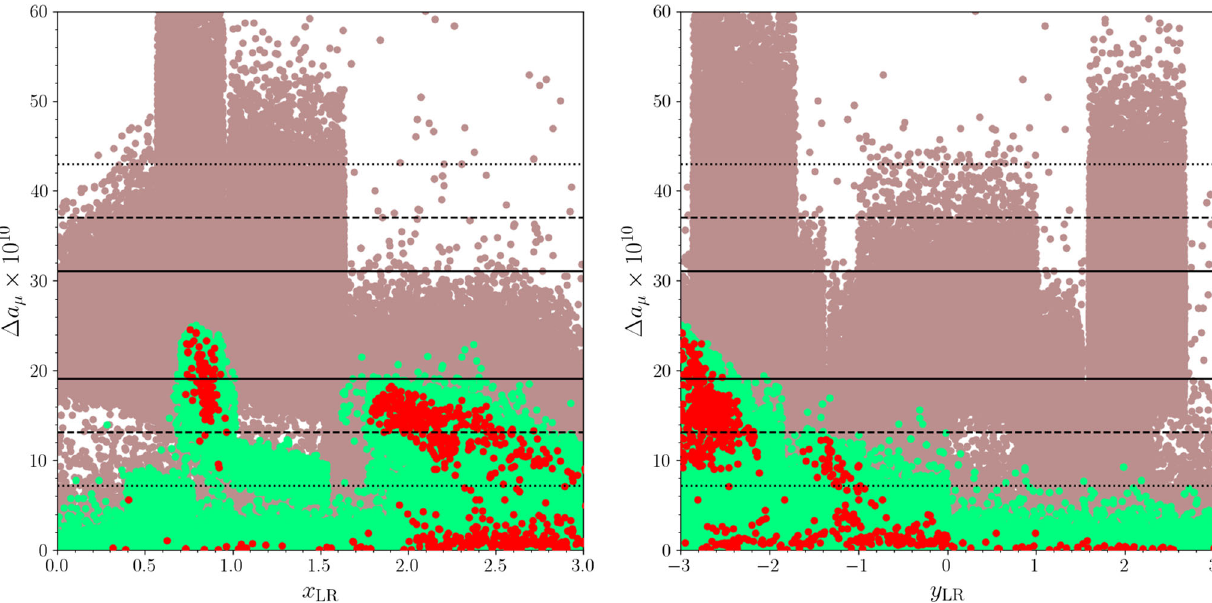
Fig. 3 LR breaking and muon g − 2 implications in the (cid:5) a μ − x LR and (cid:5) a μ − y LR planes. The meanings of colors and horizontal lines are the same as in Fig.